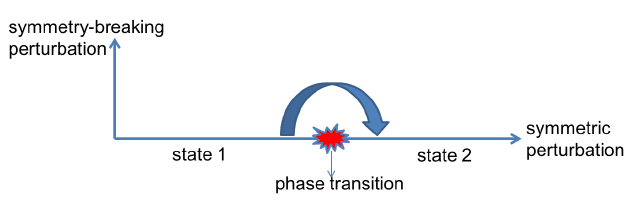
Figure 1: If two states have the same emergent order and exact microscopic